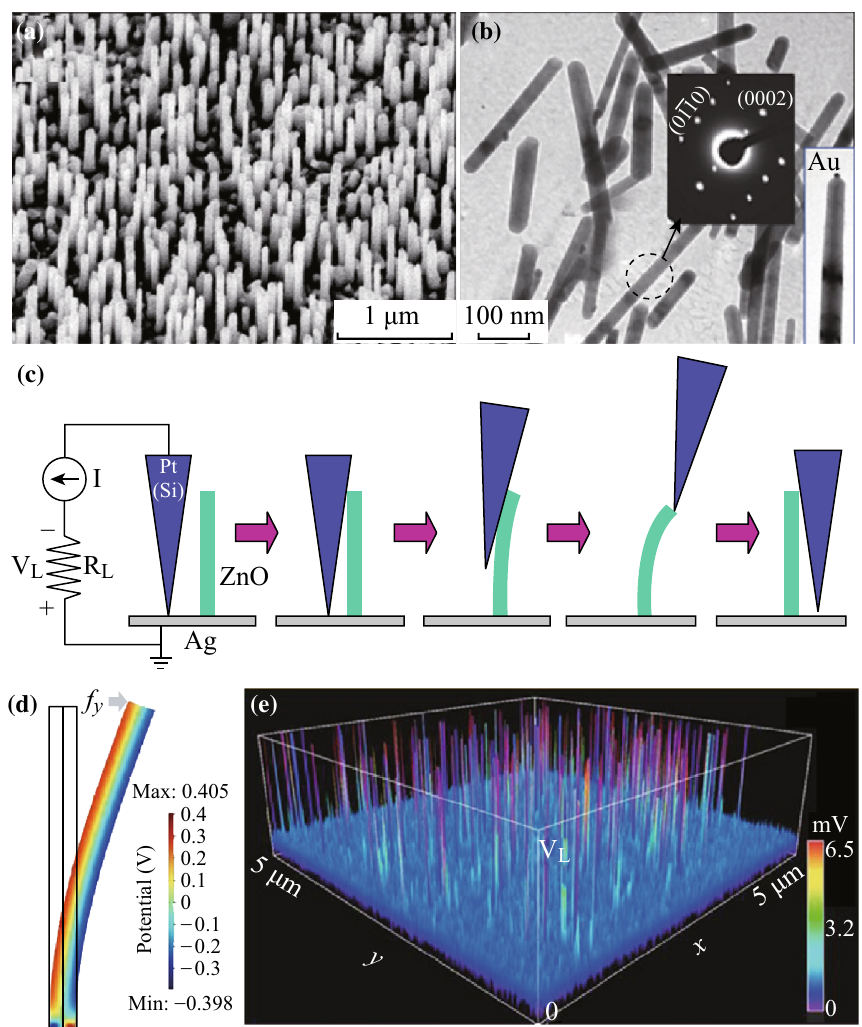
Fig. 1 Design for converting nanoscale mechanical energy into electrical energy by a vertical piezoelectric ZnO NW-based PENG. a SEM images of aligned ZnO NWs grown on a -Al 2 O 3 substrate. b TEM images of ZnO NWs, showing the typical structure of the NW without an Au particle or with a small Au particle at the top ( inset at center shows SAED pattern). c Experimental setup and procedures for generating electricity by deforming a piezoelectric NW with a conductive AFM tip. d Potential distribution for a ZnO NW in side view . e Electric signal collected by AFM on a ZnO NW array. Figures adapted from [10,